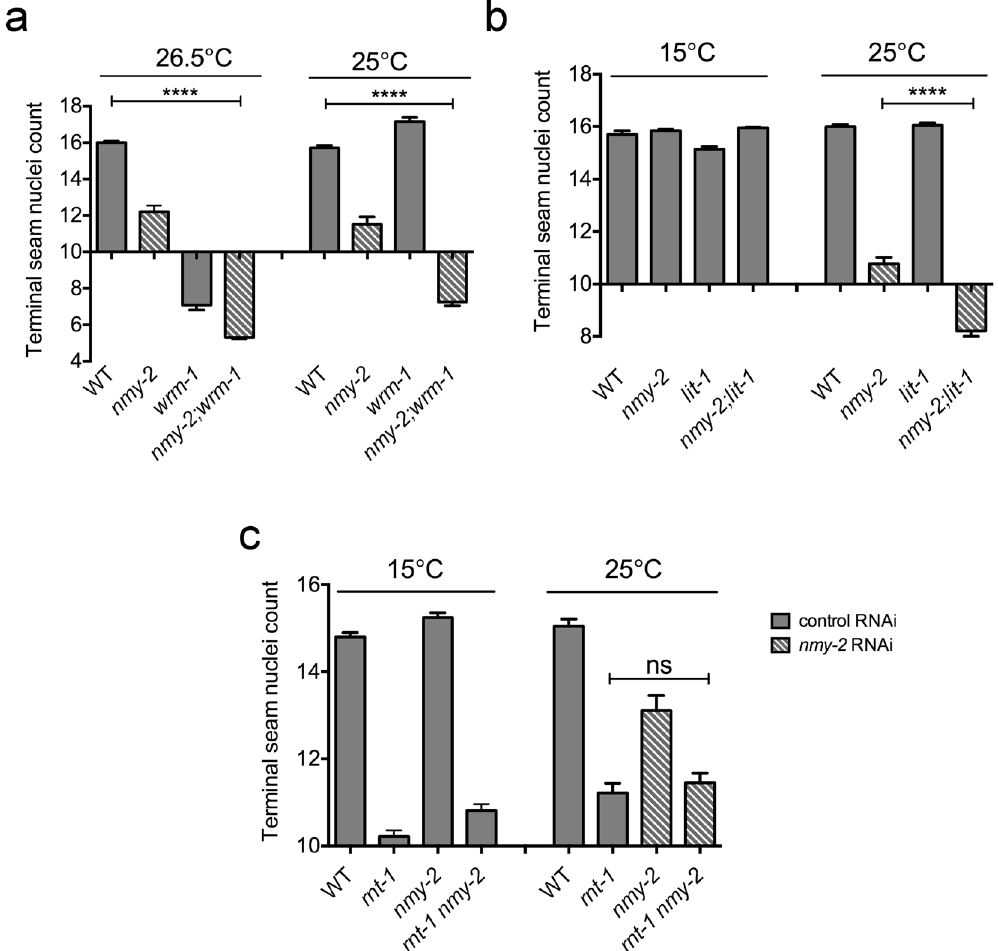
Figure 6. Epistasis analysis between nmy-2 and known seam regulators. ( a ) nmy-2 and wrm-1 . Synchronised L1 larvae for the wild-type, nmy-2 and wrm-1 single mutants, and the nmy-2 ; wrm-1 double mutant (strains AW335, AW785, EW95 and AW861, respectively) were fed the indicated RNAi bacteria at 26.5 °C or 25 °C. ( b ) nmy-2 and lit-1 . Synchronised L1 larvae for the wild-type, nmy-2 and lit-1 single mutants, and the nmy-2;lit-1 double mutant (strains AW335, AW785, AW943 and AW983, respectively) were fed the indicated RNAi bacteria at 15 °C or 25 °C. ( c ) nmy-2 and rnt-1 . Synchronised L1 larvae for the wild-type, rnt-1 and nmy-2 single mutants, and the rnt-1 nmy-2 double mutant, all in the dpy-5 background (strains AW989, AW990, AW991 and AW992, respectively), were fed the indicated RNAi bacteria at 15 °C or 25 °C. Terminal seam nuclei were counted in young adult hermaphrodites using the wIs51 seam cell marker. n > 50 for each sample. Error bars represent the SEM. Unpaired, two-tailed t -test was used to determine significance ( **** p < 0.0001; ns: p = 0.46). Three independent replicates of the experiment were